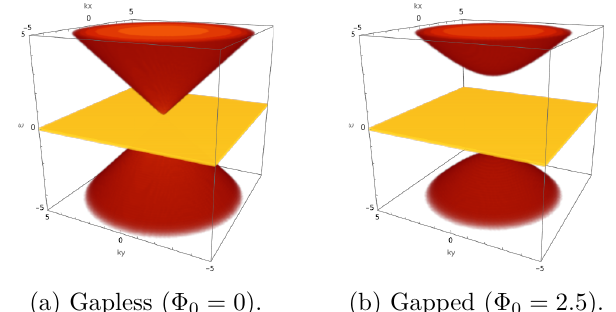
Figure 3 . Holographic realization of Lieb lattice and its gapping. (a) The boundary action R ¯ ψ Γ xy ψ without scalar coupling gives a flat band crossed by a Dirac band. (b) The Φ 1 2 bdy generates a gap between the upper and lower Dirac